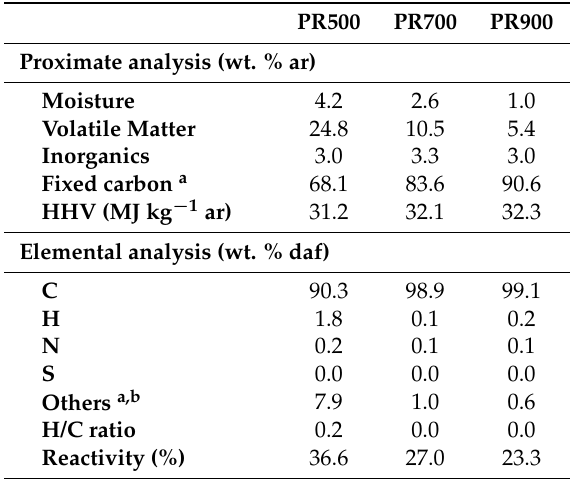
Table 8. Proximate and elemental analysis, reactivity and HHV of the solids